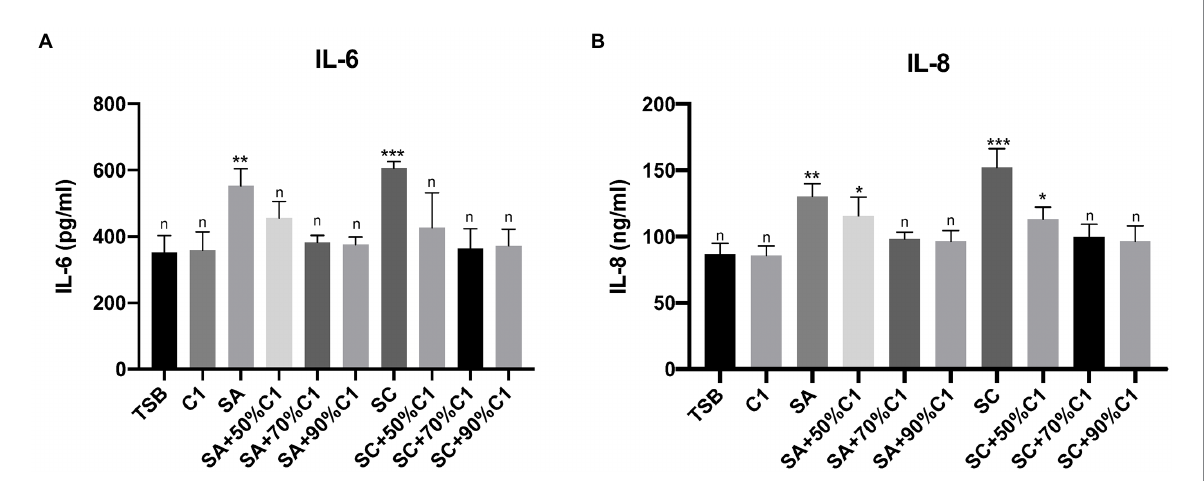
FIGURE 5 Corynebacterium accolens cell-free culture supernatants reduce S. aureus cell-free culture supernatants-induced inflammatory cytokine production to baseline. The IL-6 (A) and IL-8 (B) release by the HNEC-ALI cultures treated with the cell-free culture supernatants of C. accolens , S. aureus and co-cultured C. accolens , S. aureus in different ratio was measured. C1, C. accolens clinical isolate 1. SA, S. aureus ATCC51650. SC, S. aureus clinical strain. Experiments were performed in triplicates. * p < 0.05, ** p < 0.01, *** p < 0.001. n, no significance difference. Experiments were performed three